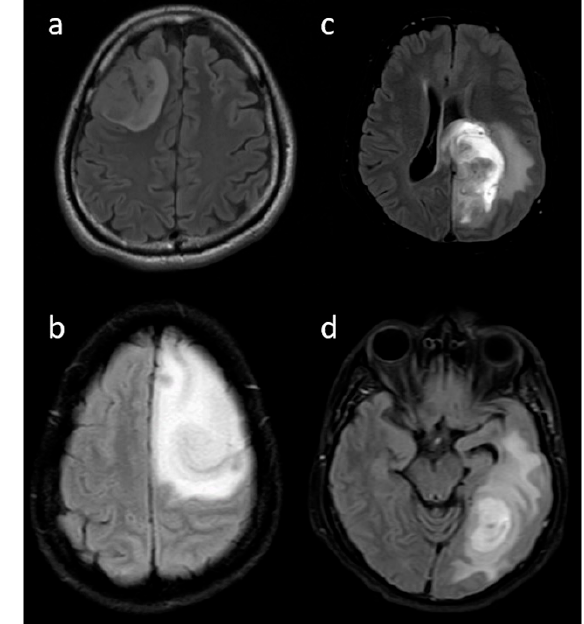
Figure 3. ( a – d ) Representative FLAIR images showing various proportions of edema: ( a ) none, ( b ) less than tumor volume, ( c ) equal to tumor volume, and ( d ) more than tumor volume.